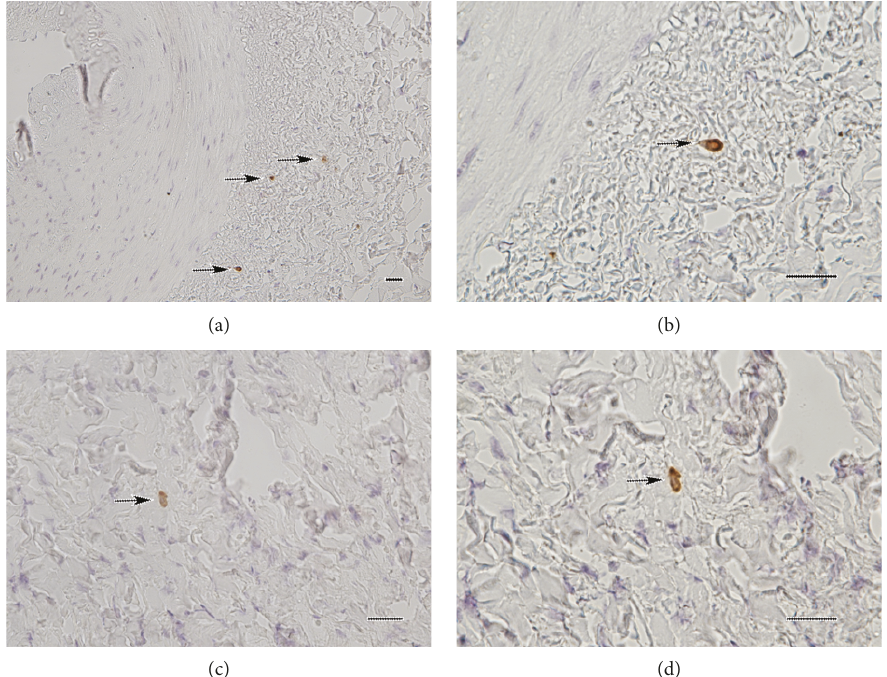
Figure 3: Immunohistochemistry showing PAI-1-positive cells (black arrows) in the adventitia of an irradiated artery (a), with a close-up showing the morphology of one such cell (b). Similarly, PAI-1-positive cells were found in the tunica externa of irradiated veins (c), with (d) a shown close-up of one such cell (scale bar=50 μ